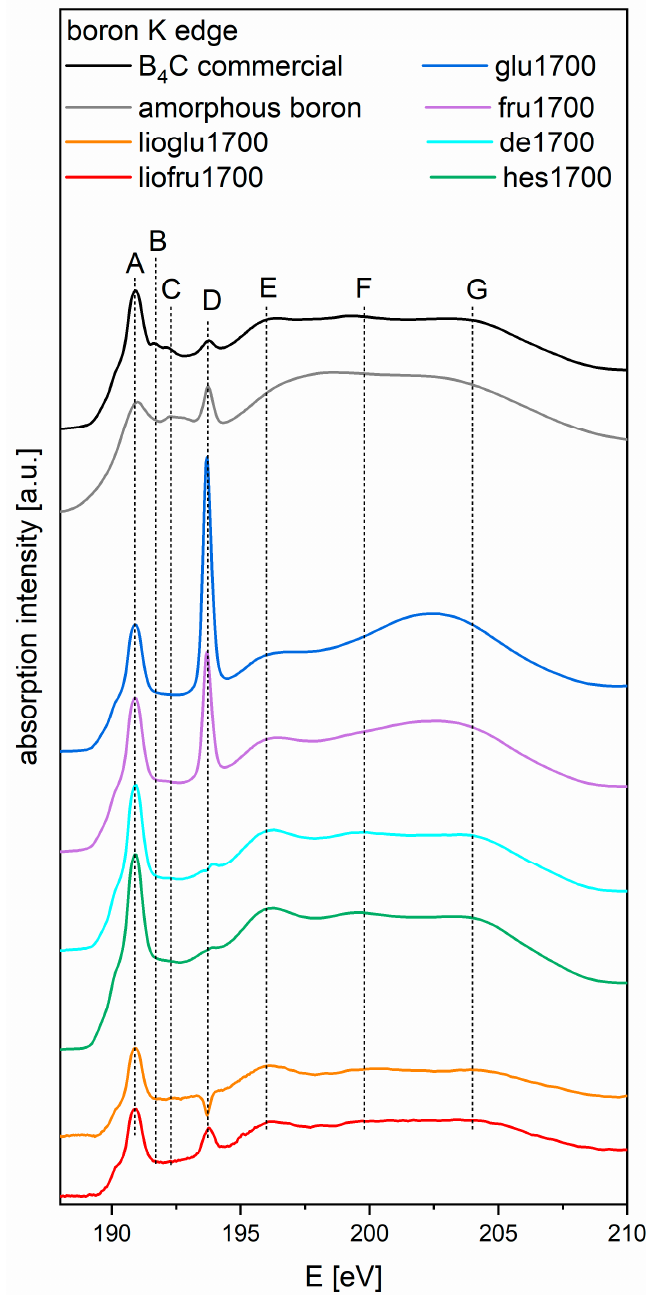
Figure 6. Boron K edge XAS spectra for powders of boron carbide obtained from recrystallized and freeze-dried precursor after pyrolyzing at 850 °C and heat treatment at 1700 °C (spectra in color) and reference spectra of commercial B 4 C (black) and amorphous boron (gray). Vertical lines indicate the characteristic spectral features for the B 4 C reference sample.